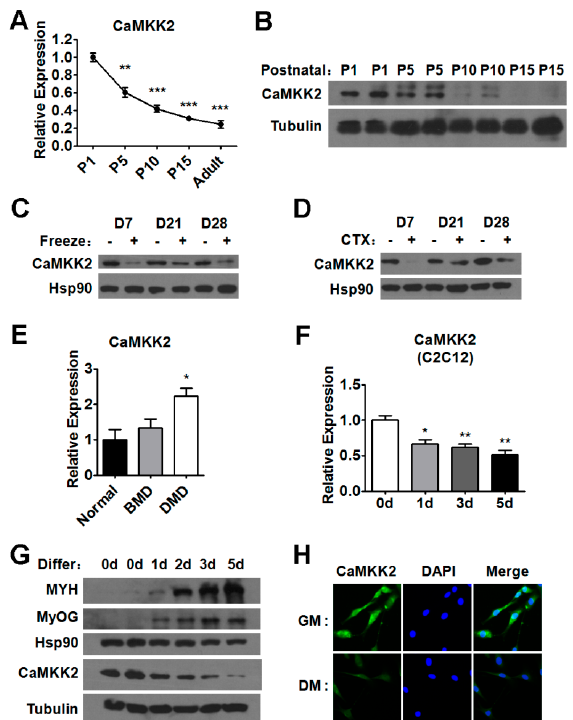
Figure 1. Expression levels of CaMKK2 in skeletal muscle during myogenesis and regeneration. ( A ) Quantitative RT-PCR analysis of CaMKK2 levels in postnatal myogenesis ( n = 4); ( B ) Representative western blot showing the CaMKK2 protein levels in postnatal myogenesis; ( C ) Representative western blot showing the CaMKK2 protein in freeze injury-induced regeneration ( n = 4); ( D ) Representative western blot showing the CaMKK2 protein levels in CTX injury-induced regeneration ( n = 4); ( E ) Quantitative RT-PCR analysis of CaMKK2 levels in BMD or DMD patients ( n = 3); ( F ) Quantitative RT-PCR analysis of CaMKK2 mRNA levels during C2C12 myoblasts differentiation ( n = 3); ( G ) Western blotting analysis of CaMKK2, MYH and MyoG protein levels during C2C12 myoblasts differentiation; and ( H ) Immunofluorescence analysis of CaMKK2 was performed in C2C12 myoblasts and myotubes (GM, growth medium; DM, differentiation medium). Experiments were repeated at least twice. Means ± SEM (error bars) are shown. *, p < 0.05; **, p < 0.01; ***, p < 0.001.